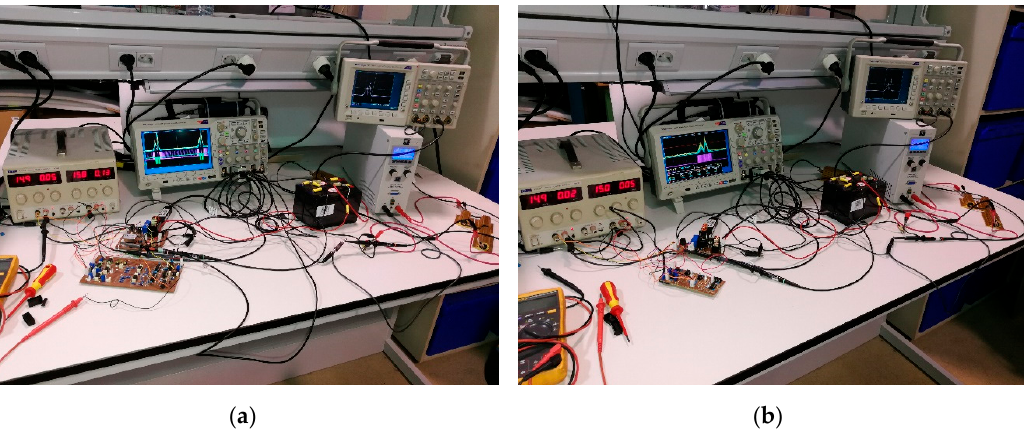
Figure 23. Experimental workbench during the test with the eperiment of Figure 22: ( a ) HBB adaptor and ( b ) Sepic